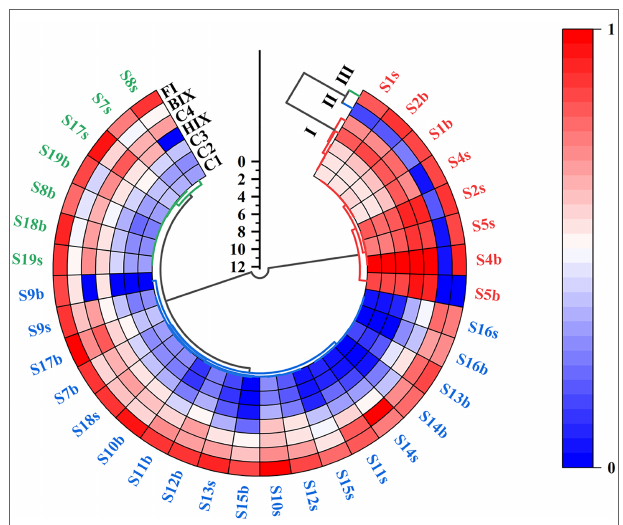
FIGURE 6 | A dendrogram with heatmap of DOM fluorescent components and optical indexes at each sampling site in Zhanjiang Bay. DOM, dissolved organic